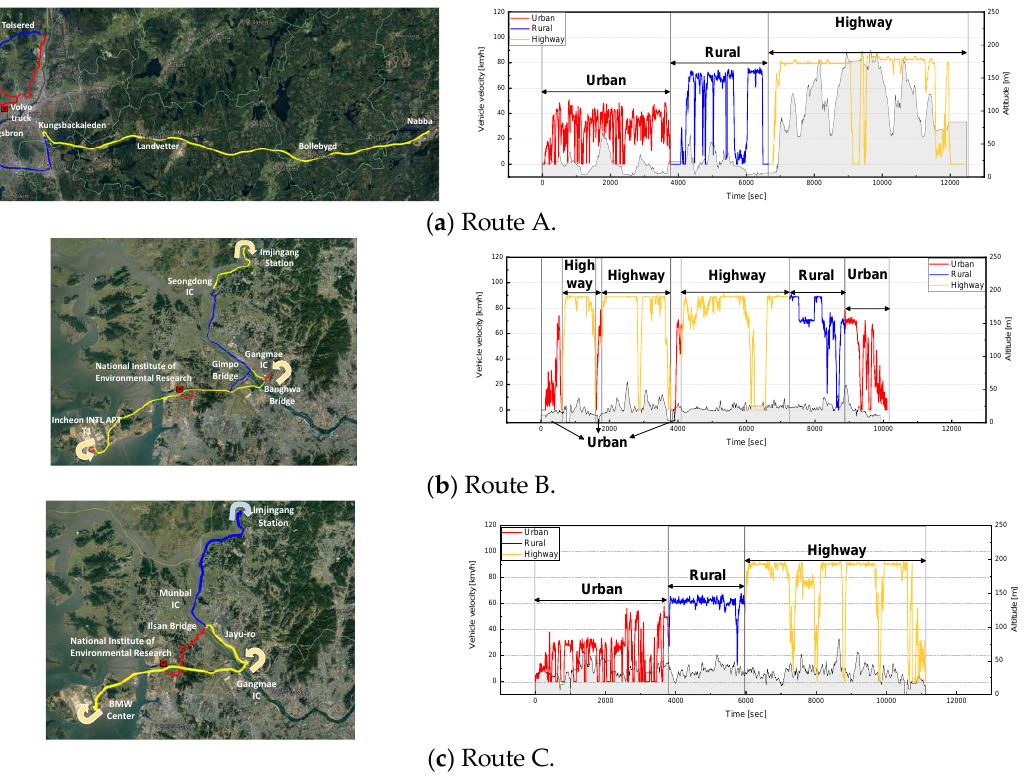
Figure 4. Time-dependent vehicle velocity profile for each route. Table 3. Driving characteristics of each route.